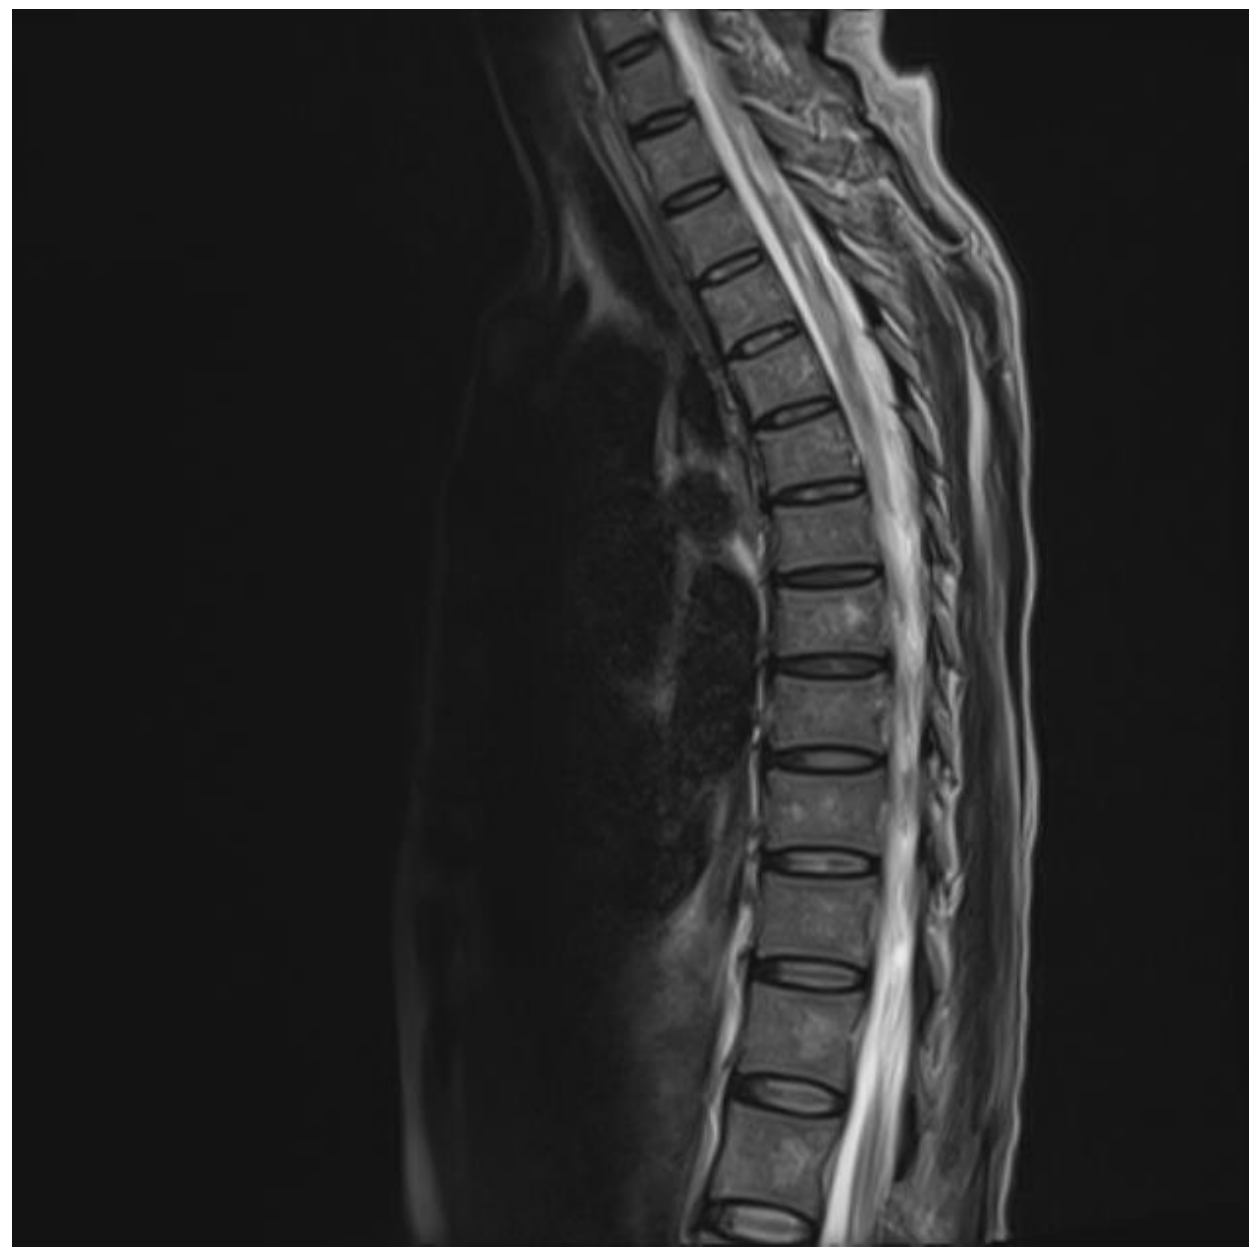
Figure 1. T2 image showing hyperintensity of the central portion of the cervical and thoracic cord. With these findings, the diagnosis of LETM was made in a patient with no evidence of immunosuppression. Ganciclovir treatment (250 mg, intravenously every 12 h for 14 days) was started, as well as methylprednisolone (1g, intravenously every 24 h for 5 days). The patient presented clinical improvement and was progressed to maintenance doses with 900 mg of valganciclovir orally every 24 h for 14 days and additional daily doses of 50 mg of prednisone with a gradual reduction. During the outpatient controls, improvement was observed: she was able to stand and walk on her